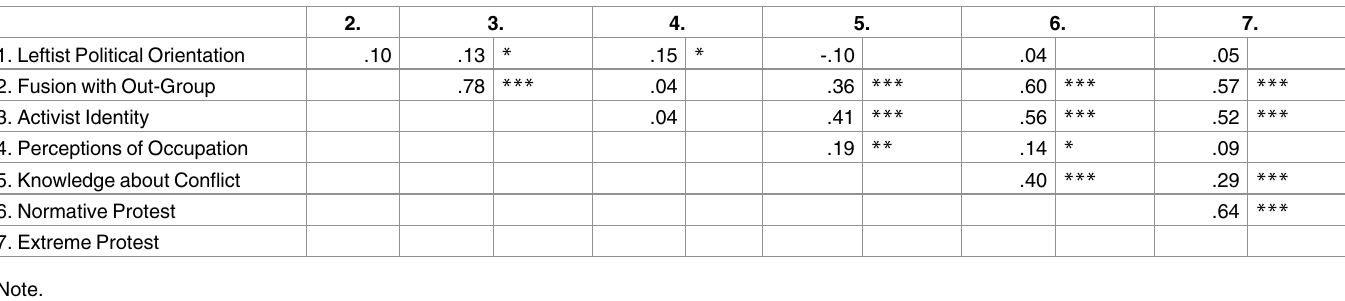
Table 5. Correlations between variables in Study 3 across conditions are displayed. 2. 3. 4. 5.